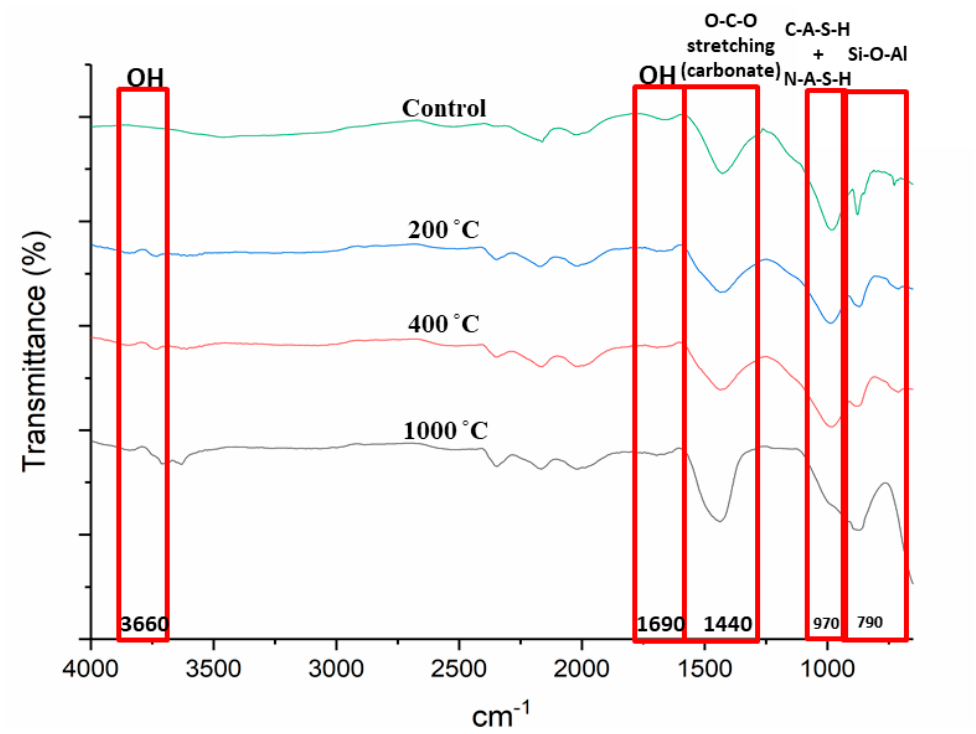
Figure 6. FTIR spectra of dolomite / fly ash geopolymer before (control) and after exposure to 200, 400, 1000 °C.